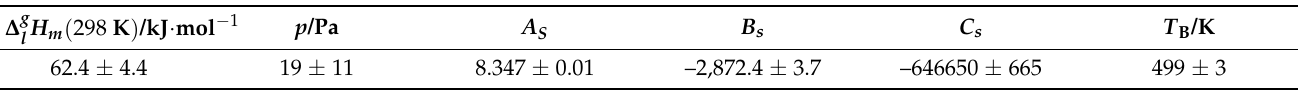
Table 8. A Summary of the Vaporization Enthalpy, Vapor Pressure at 298.15 K, Coefficients of Equation (8) and Predicted Boiling temperature at po =101,325 Pa of